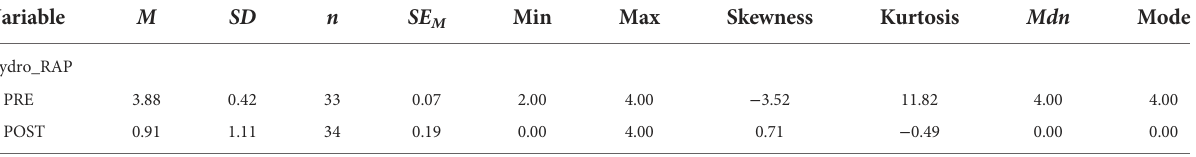
TABLE 5 Summary statistics table for interval and ratio variables by time_hydro_RAP. Variable